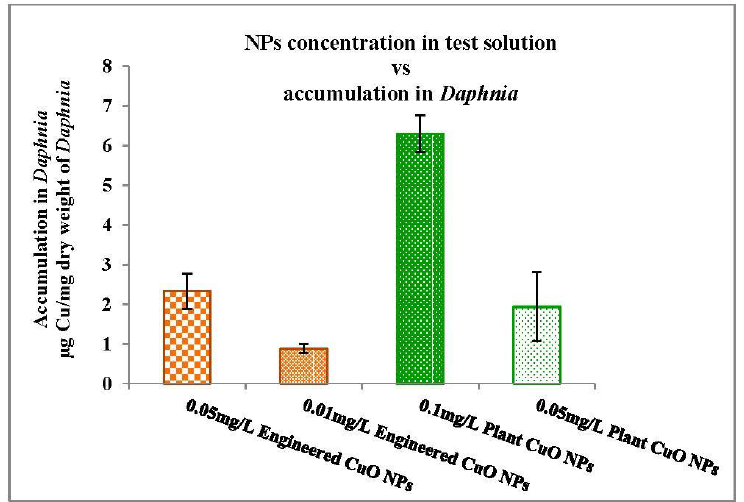
Figure 11. Accumulation of CuO NPs in Daphnia .